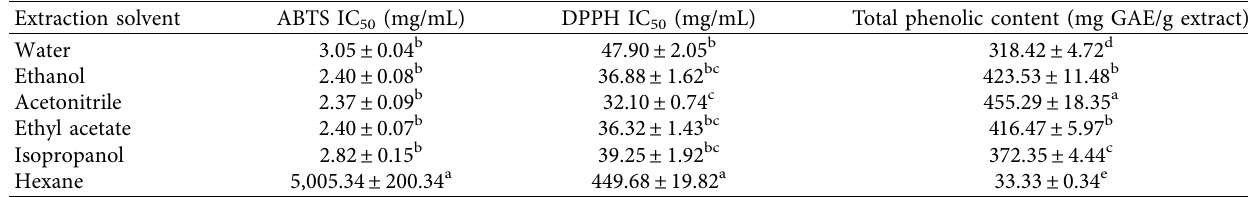
Different letters in the columns indicate significant difference ( P < 0 . 01).